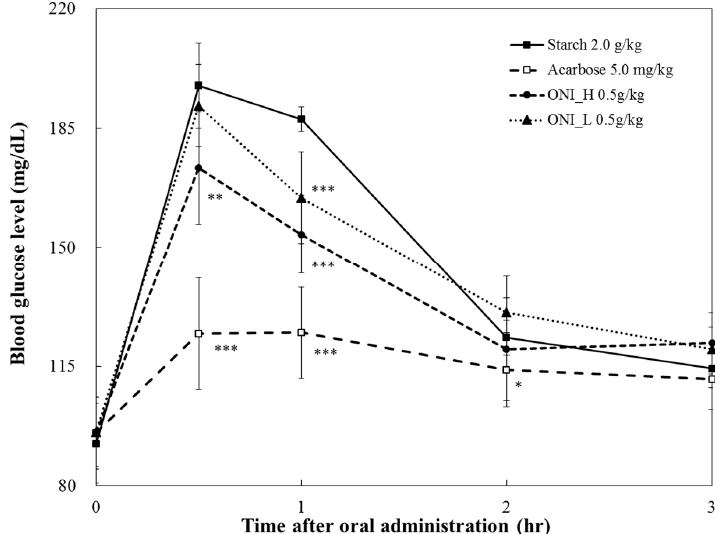
Figure 5. Comparison of postprandial blood glucose-lowering effects of pyridoxine, pyridoxal, and pyridoxamine in starch loading test. After fasting for 24 h, five-week-old, male SD rats were orally administered starch solution (2.0 g/kg) with or without samples (onion extracts). The results were expressed as mean ± S.D. Statistical significances were determined by Student’s t -test (* p < 0.05; ** p < 0.01; and *** p < 0.001).